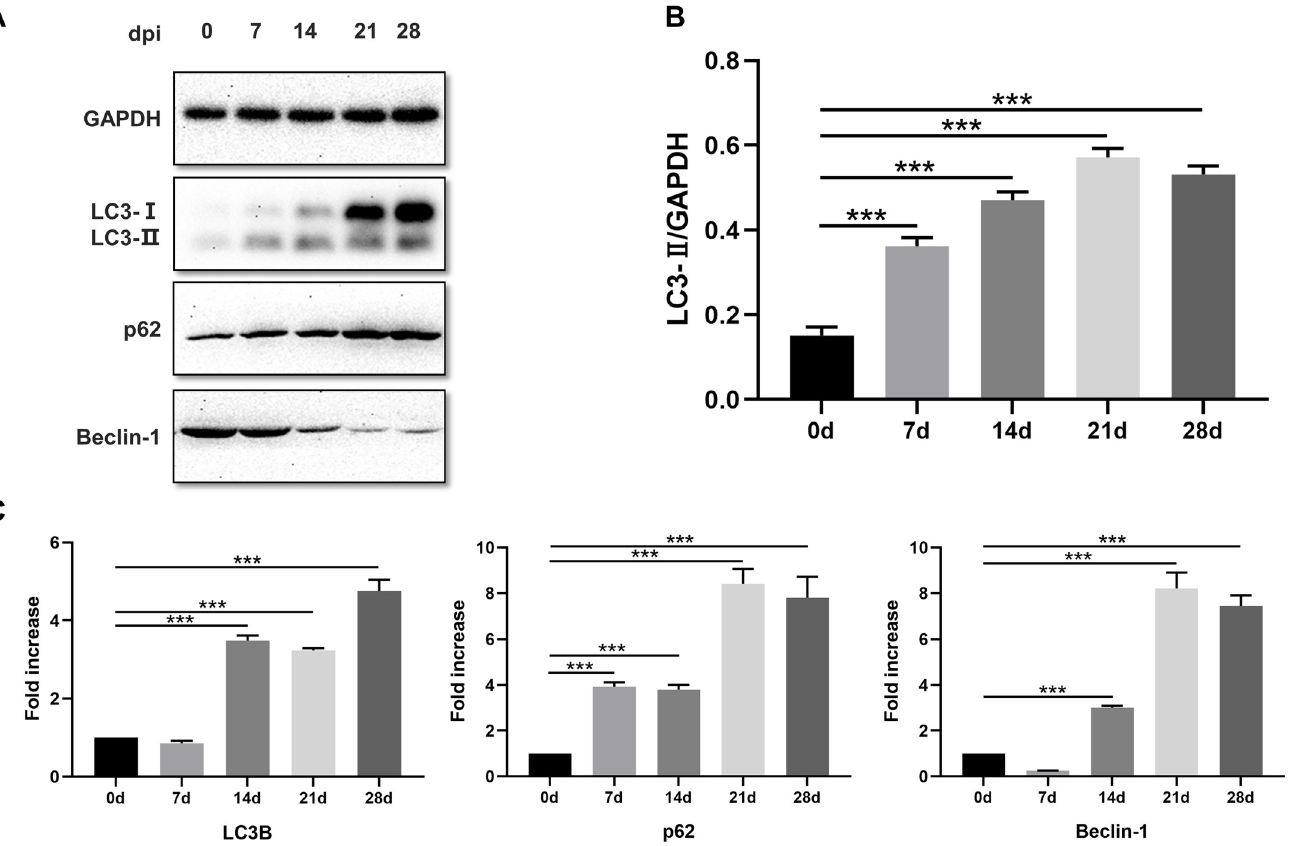
Fig 2. Protein level and transcriptional level of LC3B, p62, and Beclin-1 in T . spiralis -infected mice. A. The protein expression level of LC3B, p62, and Beclin-1 in diaphragms of T . spiralis -infected mice on 0, 7, 14, 21, and 28 dpi. B. Density ratios of the protein expression level of LC3-II and GAPDH on 0, 7, 14, 21, and 28 dpi. C. Expression of LC3B, p62, and Beclin-1 mRNA in diaphragms of T . spiralis -infected mice on 0, 7, 14, 21, and 28 dpi. The data represent at least 3 independent experiments and are expressed as mean ± SD. p < 0.05( � ), p < 0.01( �� ), p < 0.001( ���